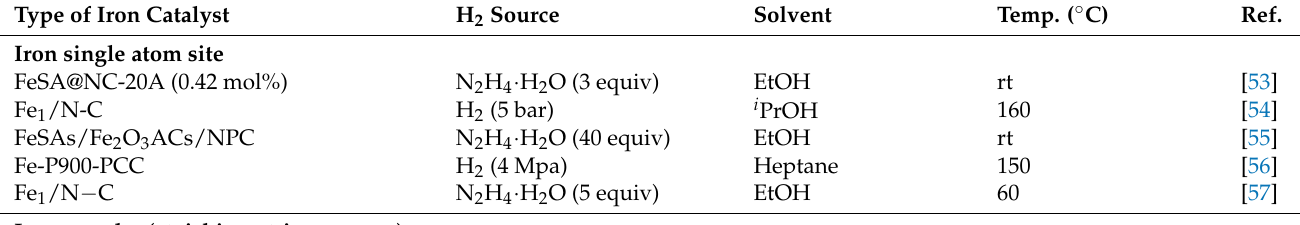
Table 1. Comparison of the reaction conditions of iron catalysts for the reduction of